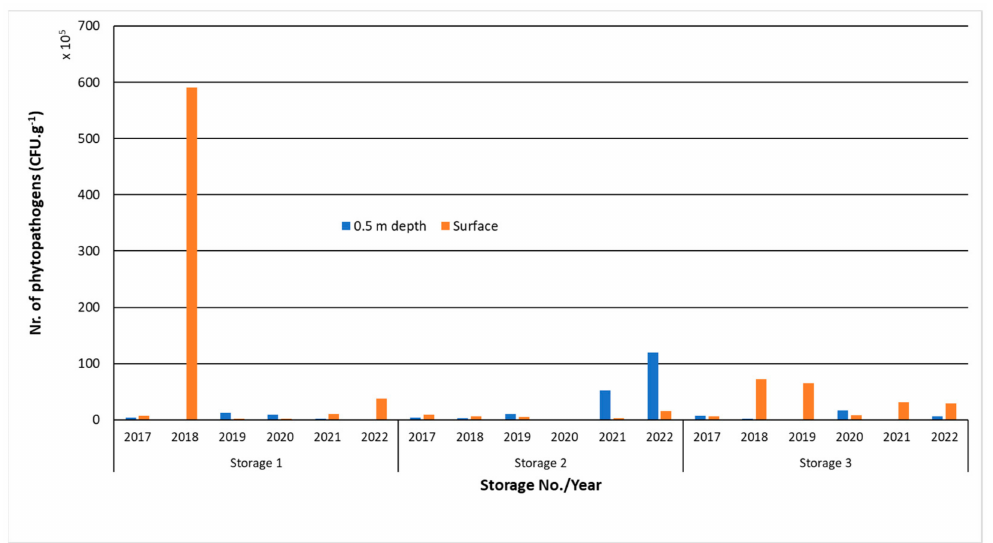
Figure 4. The number of colonies of phytopathogens per 1 g depending on the year and location of